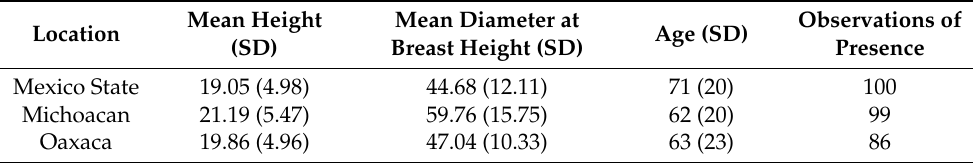
Table 4. Characteristics of the Pinus oocarpa trees used in the